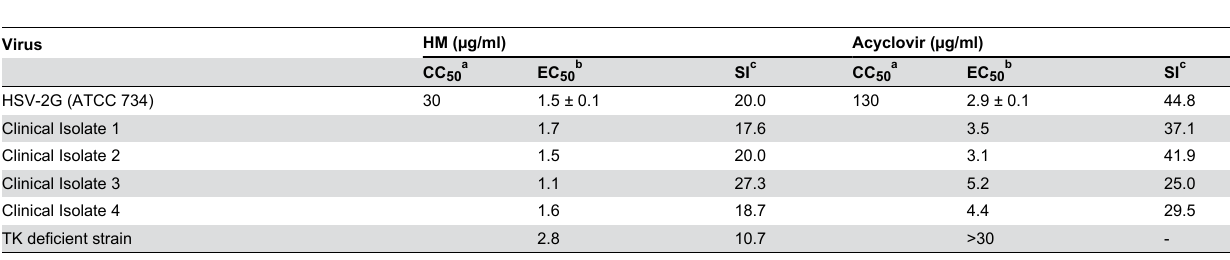
Table 1. Assessment of cytotoxicity and anti-HSV-2 activity of HM.